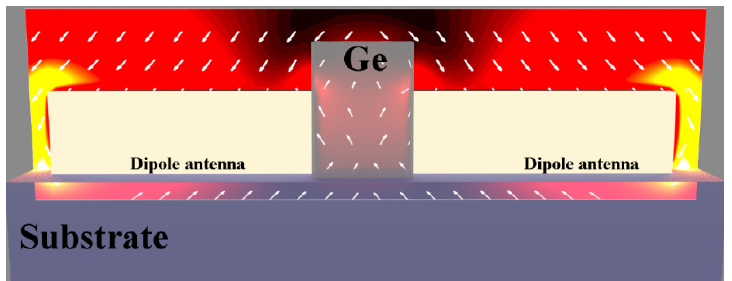
Figure 3. A nanometer-scale germanium photodetector with metal-semiconductor-metal (MSM) configuration is embedded into the gap region of half-wave Hertz dipole antenna. The dipole antenna was used to collect light from a large area and concentrate it into the small subwavelength region of the germanium photodetector [19].